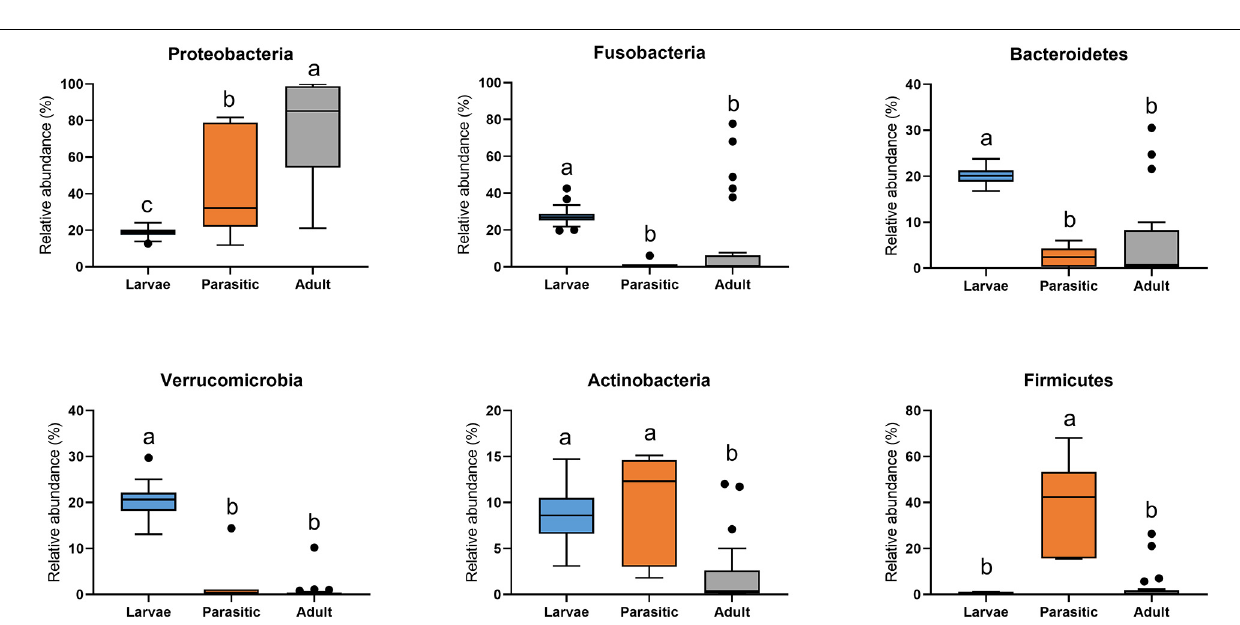
Frontiers in Microbiology |